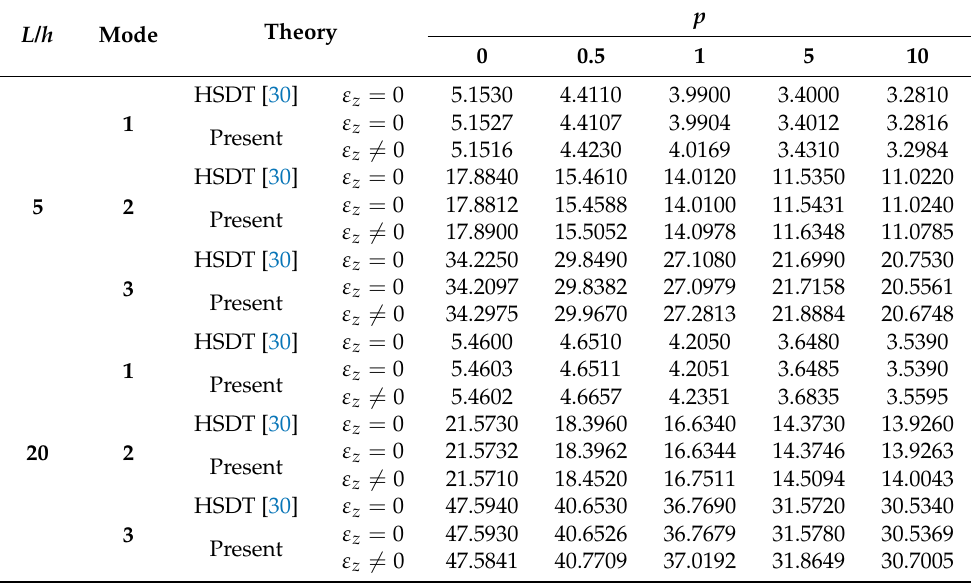
Table 4. Comparison of the S-S FG beam frequencies ω i for some values of ( L / h ) and ( p ) .